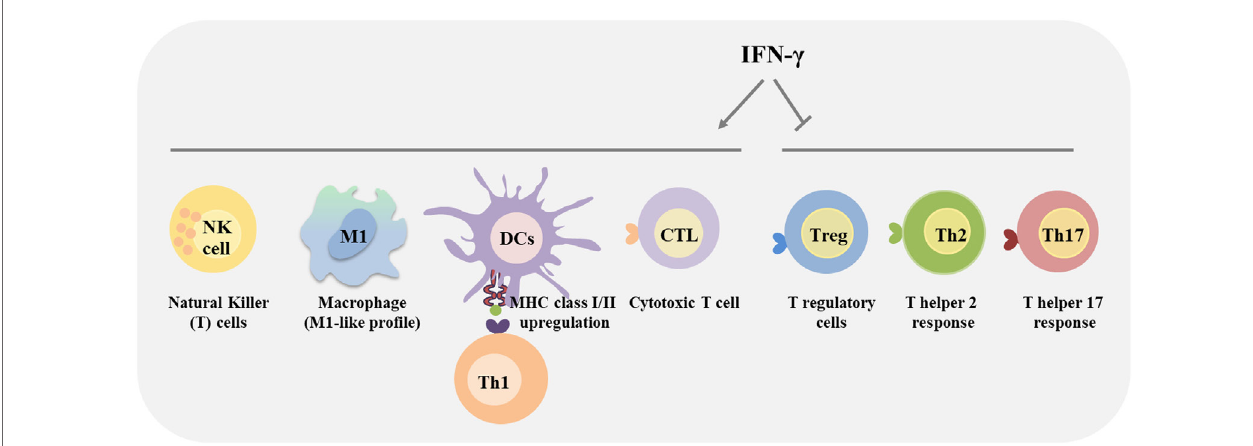
FiGURe 2 | Immunomodulatory effects of interferon-gamma (IFN- γ ). IFN- γ produced by immune cells affects the behavior of distinct immune cells within the tumor microenvironment. Specifically, IFN- γ plays a major role in activating anticancer immunity, by promoting the activity of CD4 T helper type 1 cells, CD8 cytotoxic T lymphocyte (CTL), natural killer (NK) cells, dendritic cells (DCs), and macrophages, promoting the antigen presentation. Additionally, IFN- γ activates macrophages towards a more pro-inflammatory and tumoricidal phenotype (M1-like). Alternatively, IFN- γ inhibits regulatory T (Treg) cells, Th2 and Th17 differentiation and